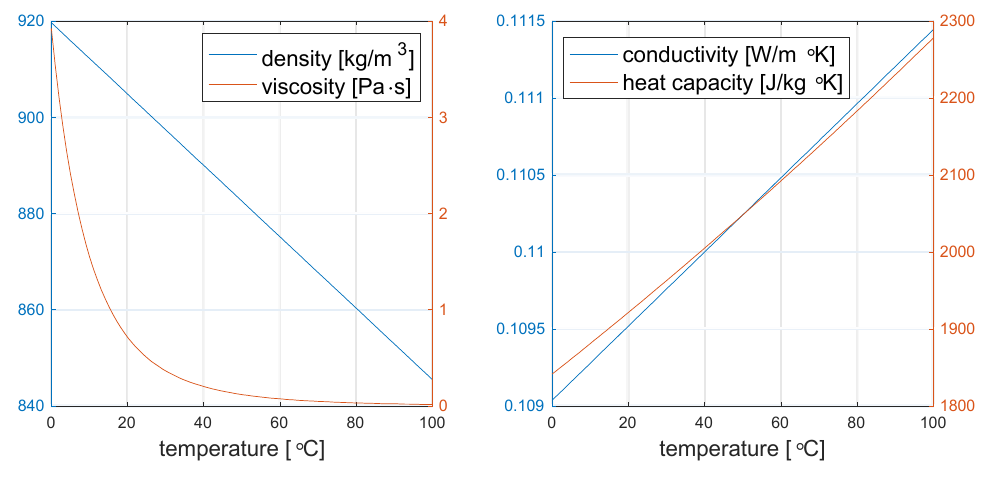
Figure 1. Parameter dependencies on temperature for SAE90 oil [1].